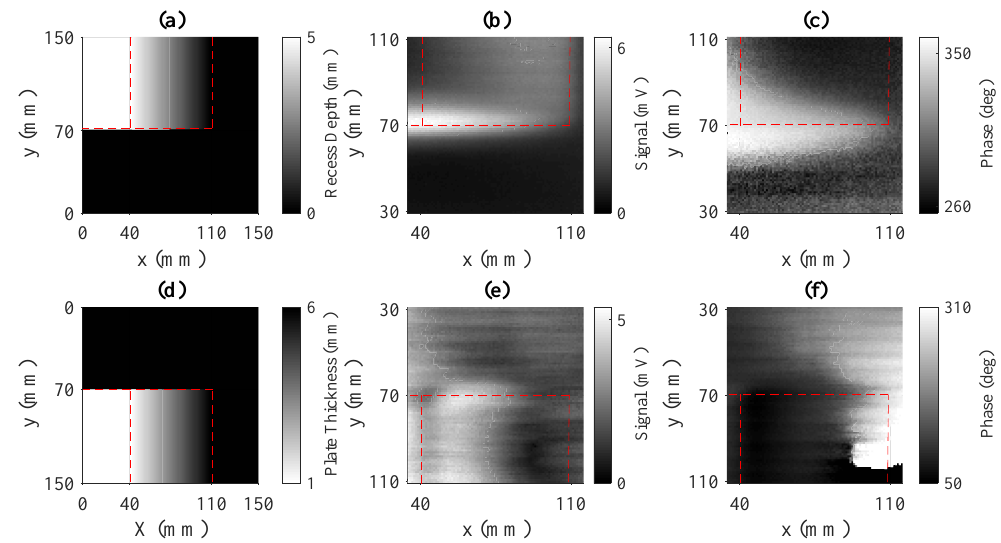
Figure 2. (colour online) The measured change of the amplitude ( b , e )/phase ( c , f ) of the rf signal over a 64 × 64 mm 2 area of a 6mm- thick aluminium plate with a single recess, whose depth changes from 0mm to 5mm (right to left). Images ( b , c ) are recorded with the recess on the top surface, while in ( e ), ( f ) the recessed surface is facing away from the sensor. Change of the recess depth, and inversely the plate thickness, is shown in ( a , d ), respectively. To record images ( b , c , e , f ), the same plate was simply flipped by 180 ◦ . Red dashed line marks a position of the edge of the